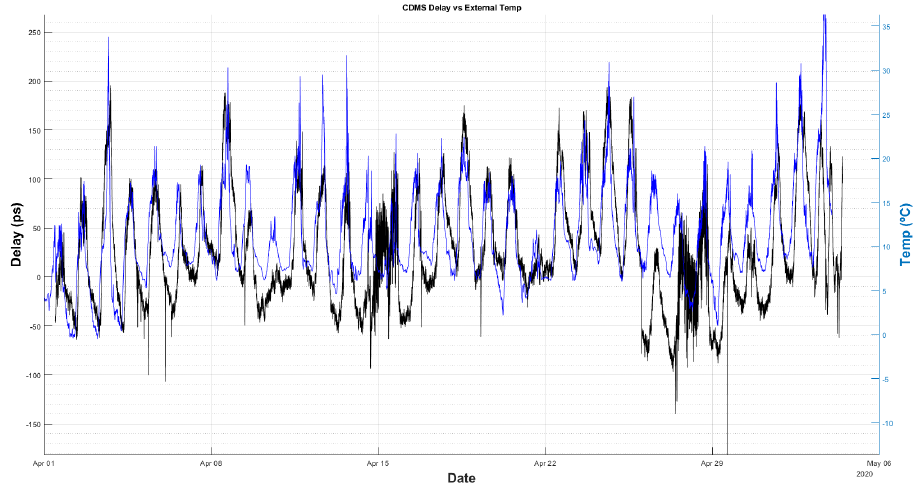
Figure 20. Comparison between delay (black) and ambient temperature